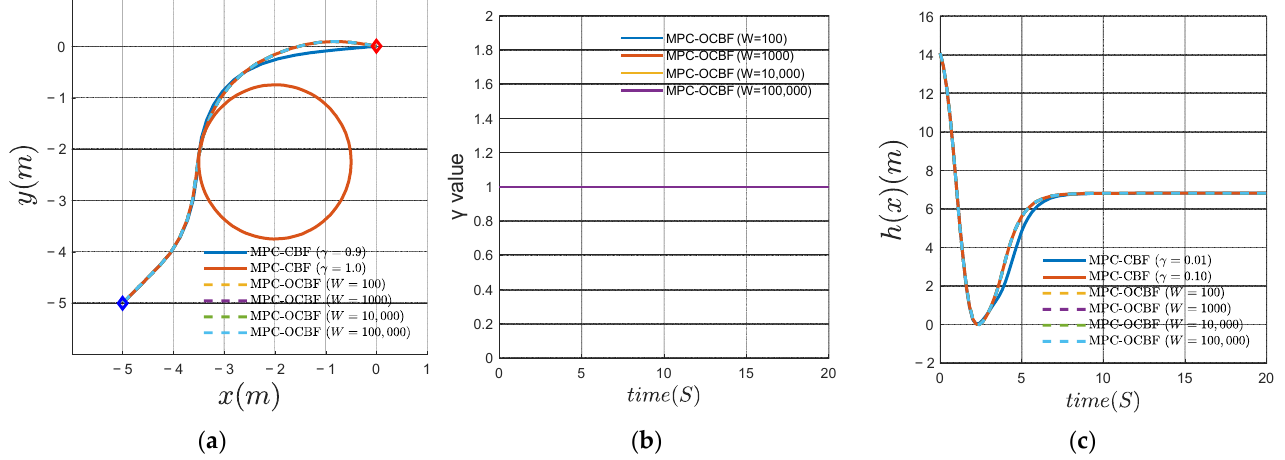
Figure 3. Compare the aggressive obstacle avoidance behaviors generated by MPC-CBF and MPC- OCBF: ( a ) the trajectory of MPC-CBF and MPC-OCBF; ( b ) the optimized  value of MPC-OCBF